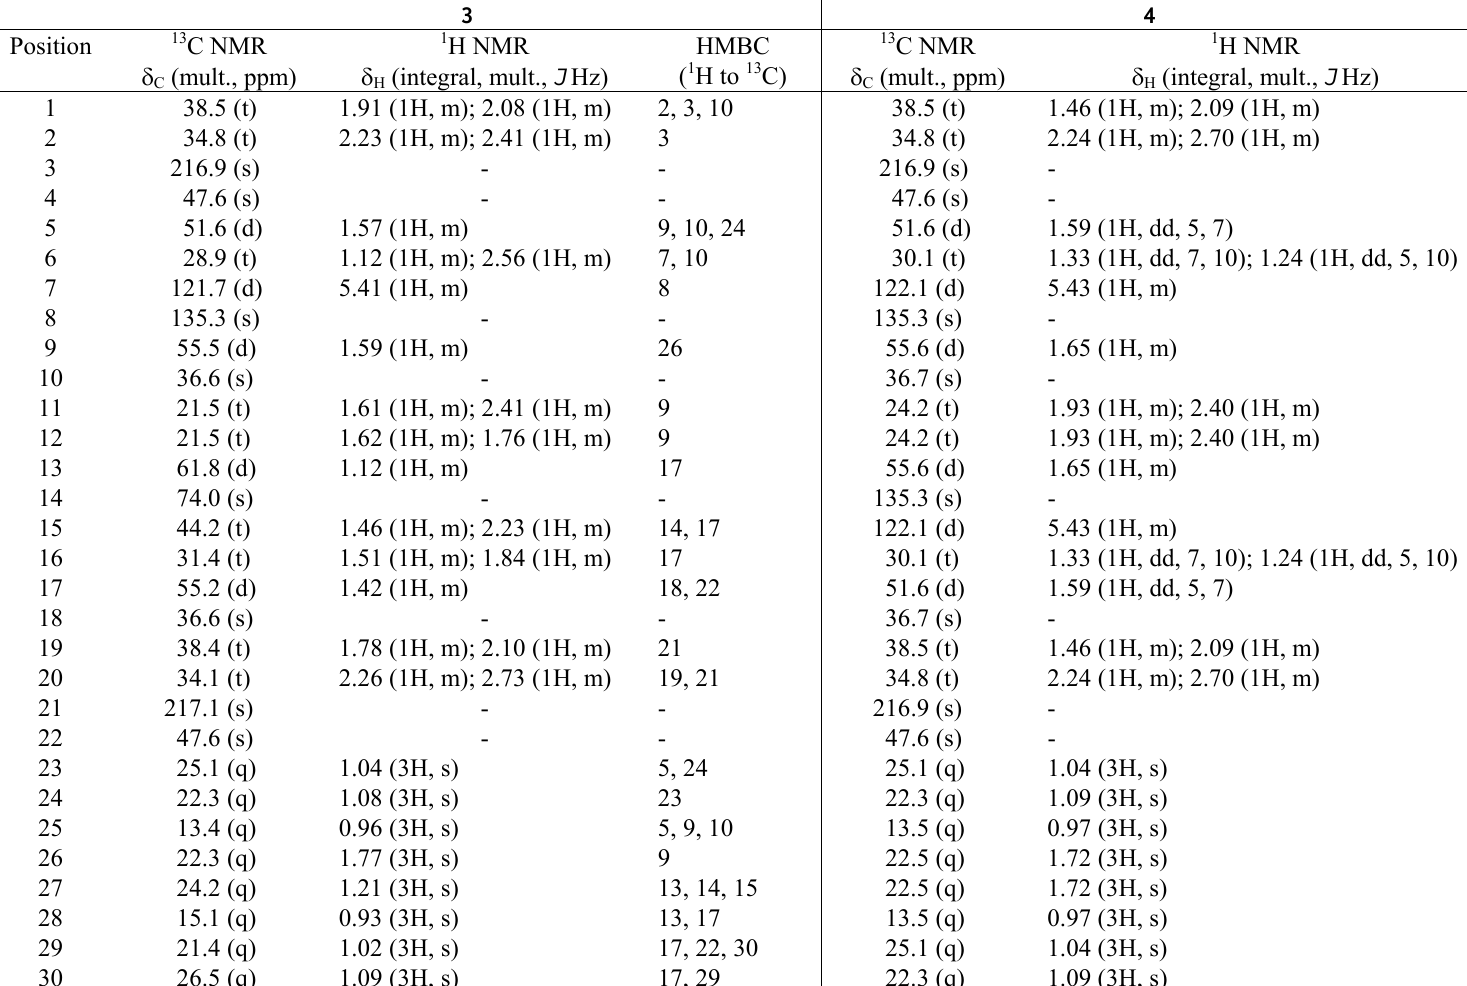
Table 2. NMR spectral data for compound 3 and 4 .